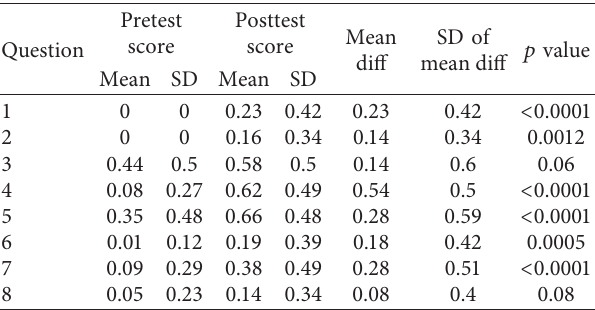
Table 4: Scores of each individual question before and after STI